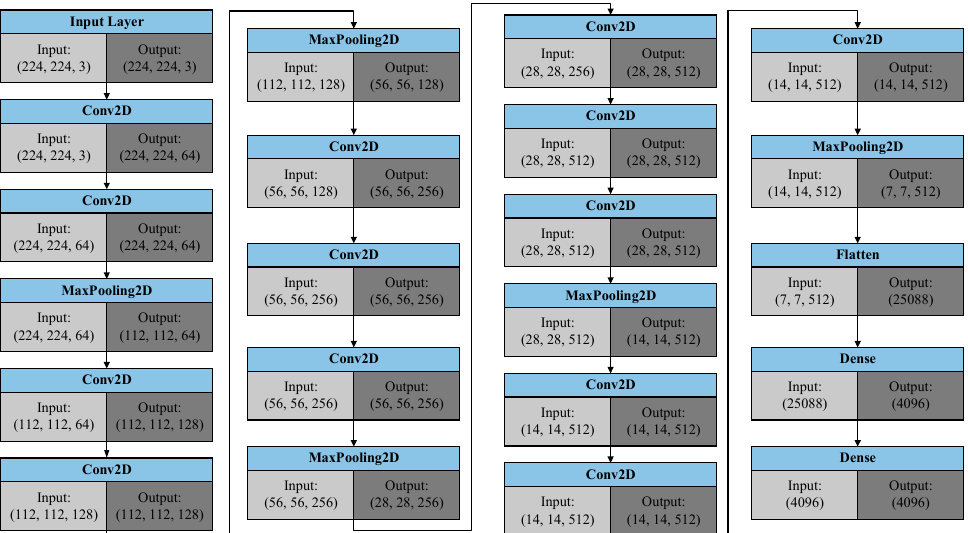
Figure A1. Architecture of the VGG16 model.